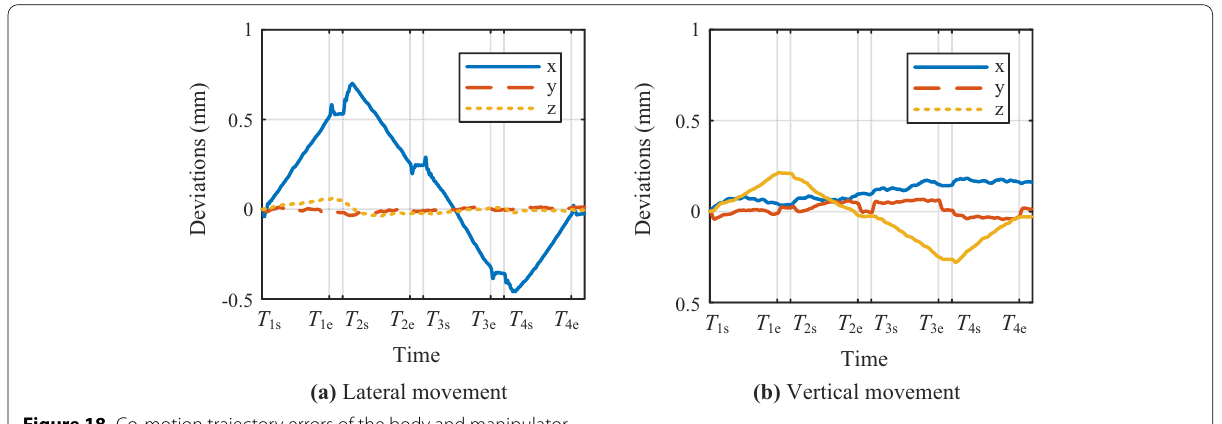
Figure 18 Co-motion trajectory errors of the body and